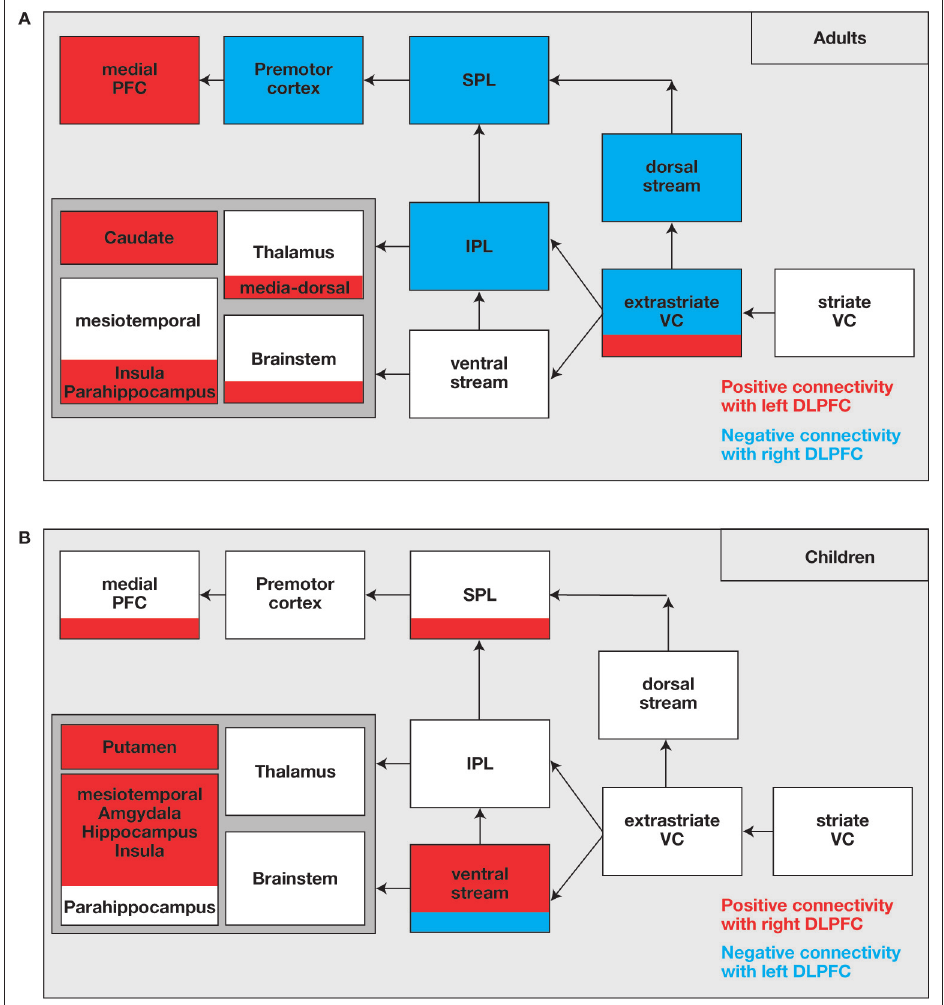
Figure 3 | (A) Network, which is down-regulated (in blue) or up-regulated (in red) by the right-sided or left-sided DLPFC in adults. The down-regulated brain areas show “negative connectivity” with the right-sided DLPFC implying that strong activation of the right-sided DLPFC is associated with reduced activation in the network (and vice versa). The up-regulated brain areas show “positive connectivity” with the left-sided DLPFC. (B) The network shows “positive connectivity” with the right-sided DLPFC and “negative connectivity” with the left-sided DLPFC in children. Actually, there is no down-regulation but rather an up-regulation by the right-sided DLPFC in